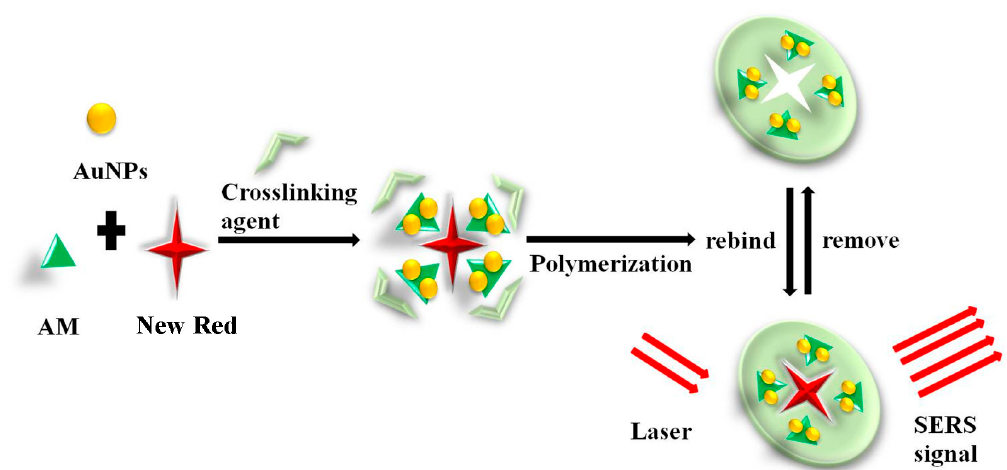
Figure 1. Schematic illustration of the preparation and recognition of molecularly imprinted hydrogel (MIH) and its application in surface-enhanced Raman spectroscopy (SERS) detection of New Red.